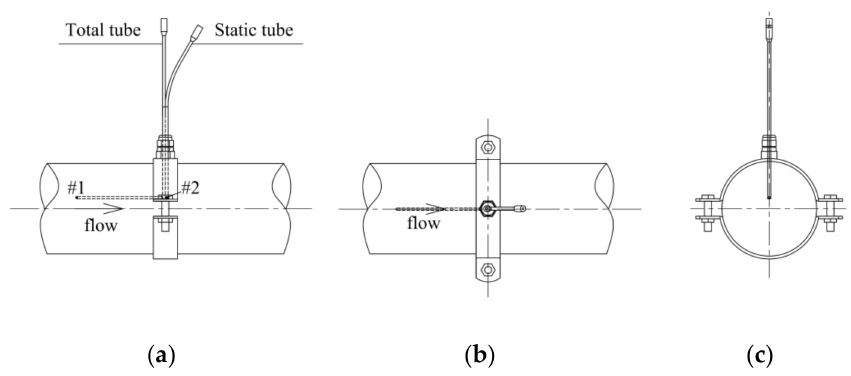
Figure 2. Improved Pitot tube schematic diagram: ( a ) longitudinal; ( b ) plan; and ( c ) section.